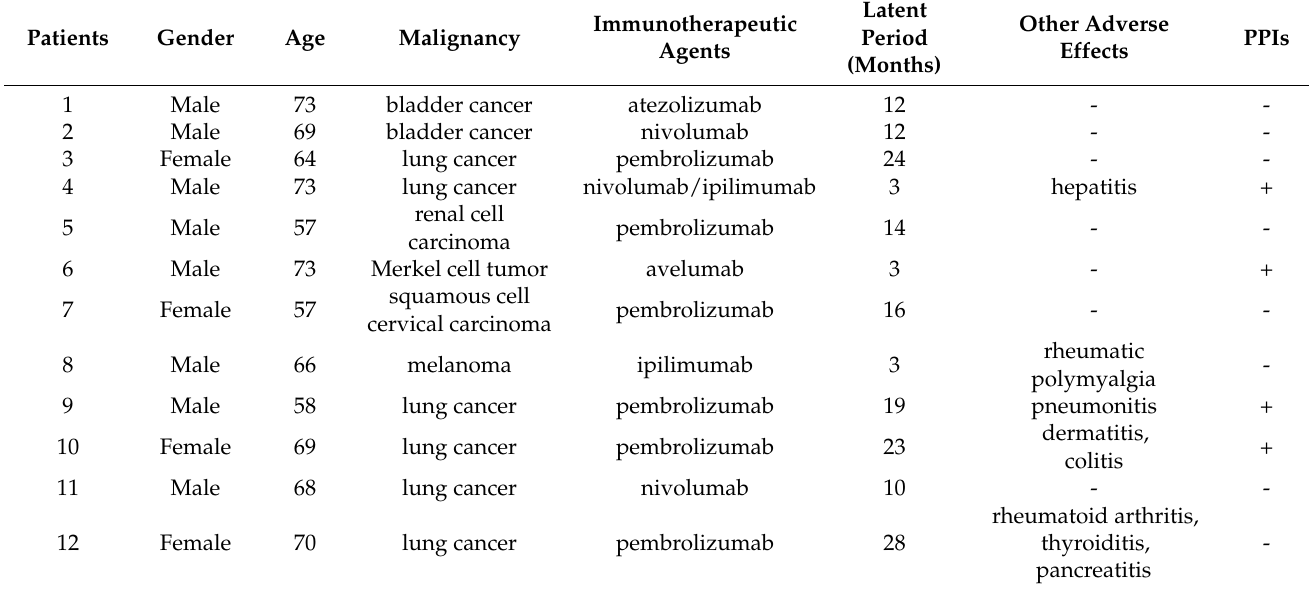
Table 1. Patients’ demographics and clinical characteristics. Yes: +, No: